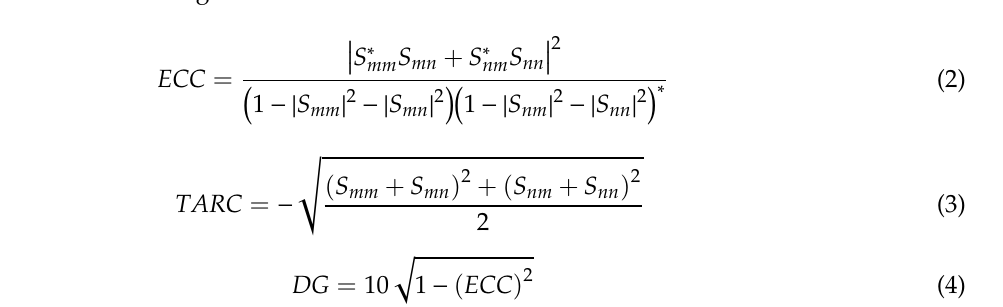
Figure 14. Measured (dash line ) and simulated (solid line) results of the antenna patterns at ( a ) 3 GHz, (b ) 6 GHz, and (c) 9 GHz.